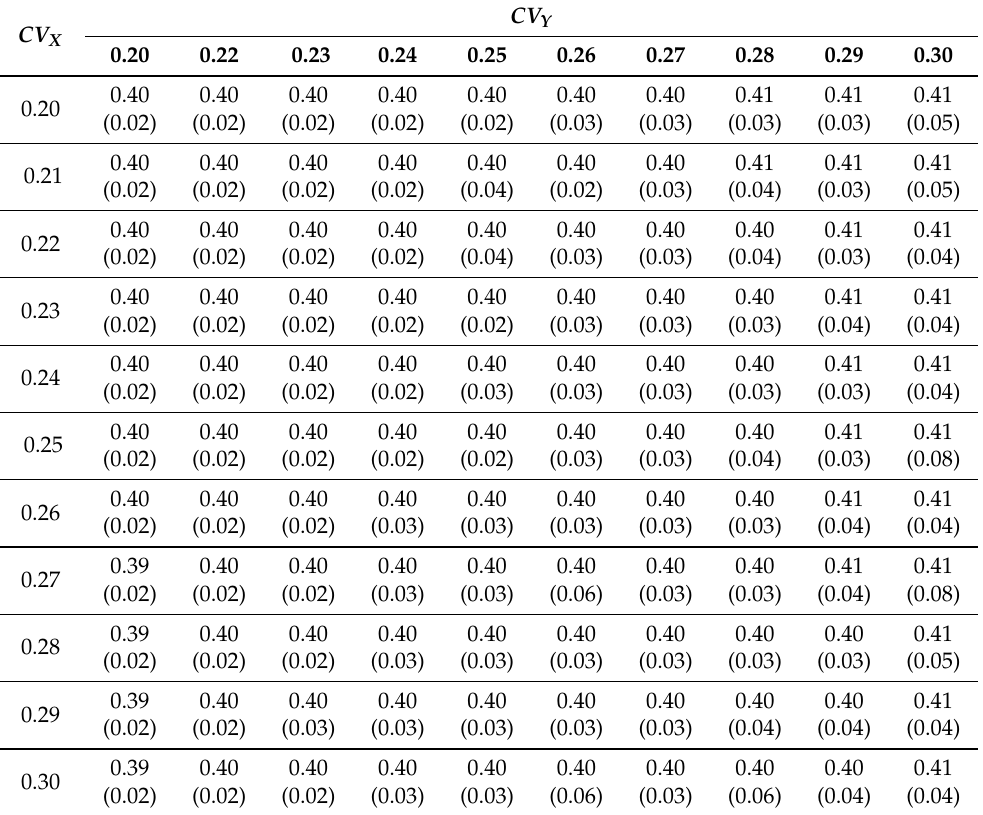
Table A1. Simulation of the ratio distribution: mean values of the fractional moment of the sec- ond order and standard deviations (in brackets) for 5000 values of 10 pairs of observations X i / Y i , where X i ∼ N ( µ X , σ X ) and Y i ∼ N ( µ Y , σ Y ) , under varying coefficients of variation of Y and X , (cid:112) µ X / µ Y = with